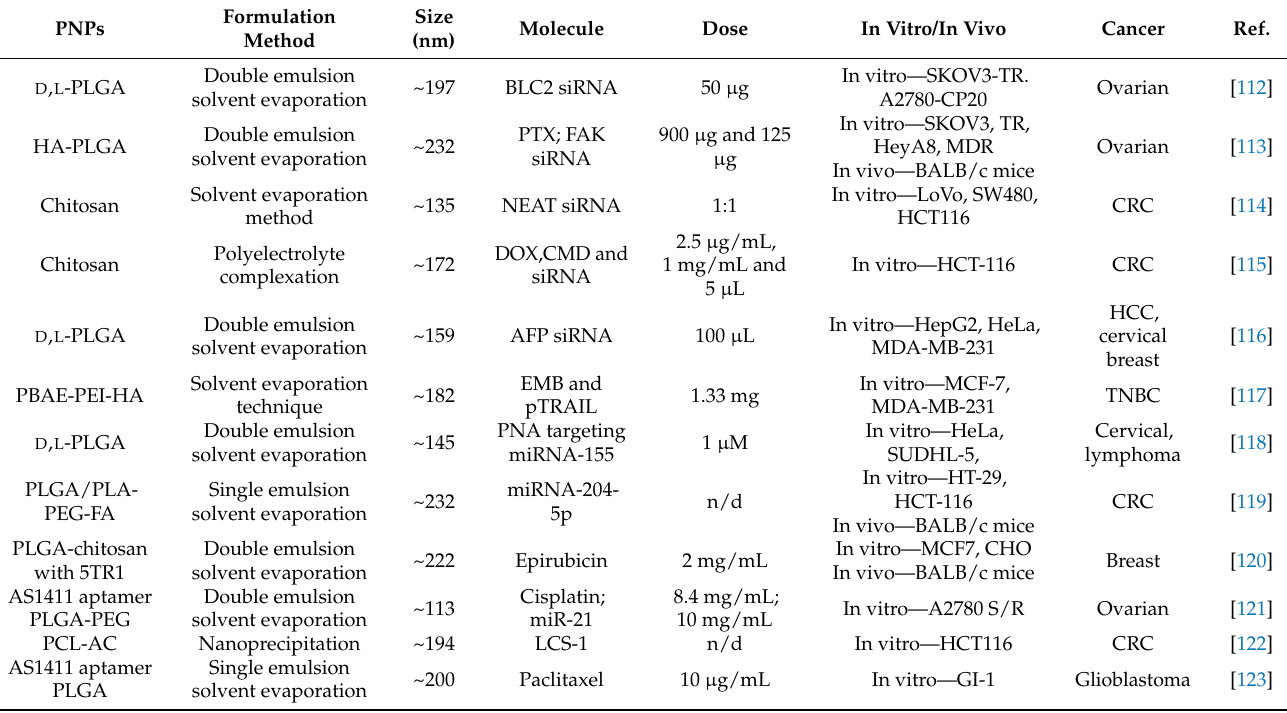
Table 7. Examples of PNPs as gene delivery system in cancer